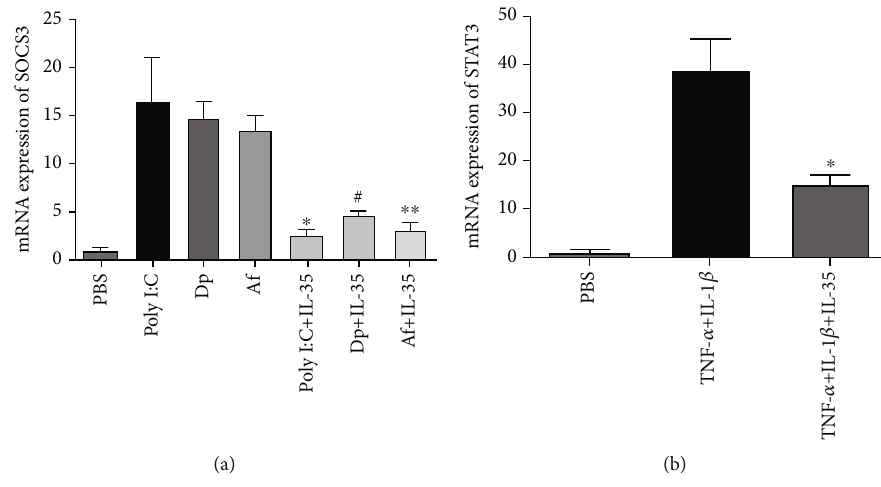
Figure 3: The expression of SOCS3 and STAT3 by human nasal epithelial cells after various stimulators. (a) The mRNA expression of SOCS3 by human nasal epithelial cells. Poly I:C: 25 μ g/mL polyinosinic-polycytidylic acid; Dp: 1.6 μ g/mL of Dermatophagoides pteronyssinus; Af: 2.6 μ g/mL of Aspergillus fumigatus; IL-35: 100 ng/mL interleukin-35. ∗ Compared with Poly I:C, P < 0 : 05 ; # compared with Dp, P < 0 : 05 ; ∗∗ compared with Af, P < 0 : 05 . (b) The mRNA expression of STAT3 by human nasal epithelial cells. Stimulators included 10ng/mL of TNF- α , 0.1ng/mL of IL-1 β , and 100 ng/mL interleukin-35. ∗ Compared with TNF- α +IL-1 β , P < 0 : 05 . Three independent tests were performed for every experiment.